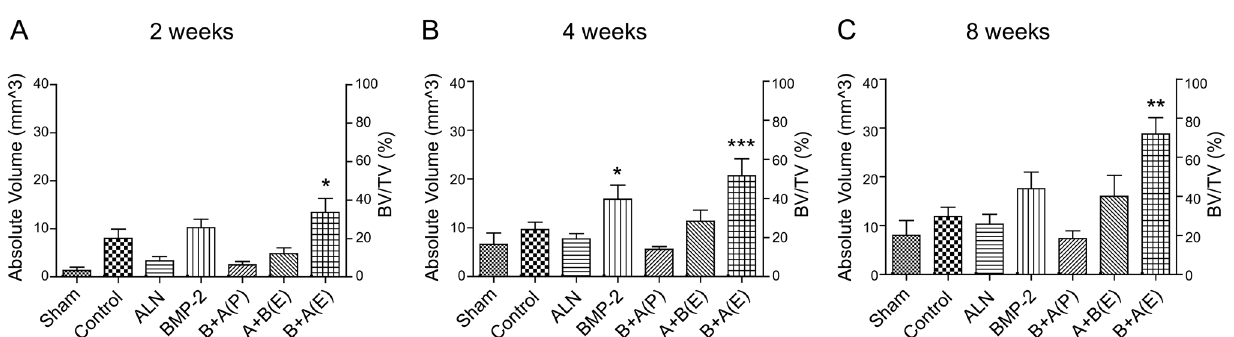
Figure 6. Quantitative analysis of new bone volume at 2, 4 and 8 weeks postoperatively. µ-CT based histomorphometry analysis of the defect site showing the amount of highly mineralized volume and BV/TV percentage at the defect site at each time point (2, 4, and 8 weeks). (* p < 0.05; ** p < 0.01; *** p < 0.001 vs. control group; one-way ANOVA